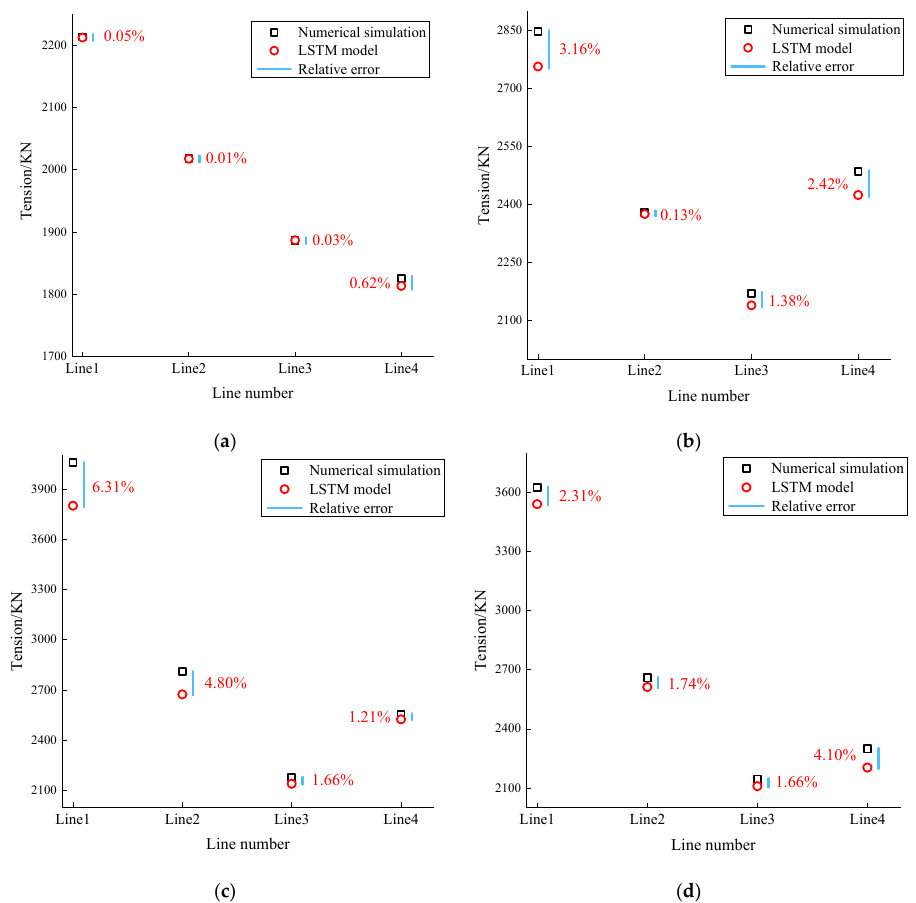
Figure 10. Comparison of the E max of mooring lines under sea state 4–7. ( a ) Sea state 4; ( b ) sea state 5; ( c ) sea state 6; and ( d ) sea state 7.